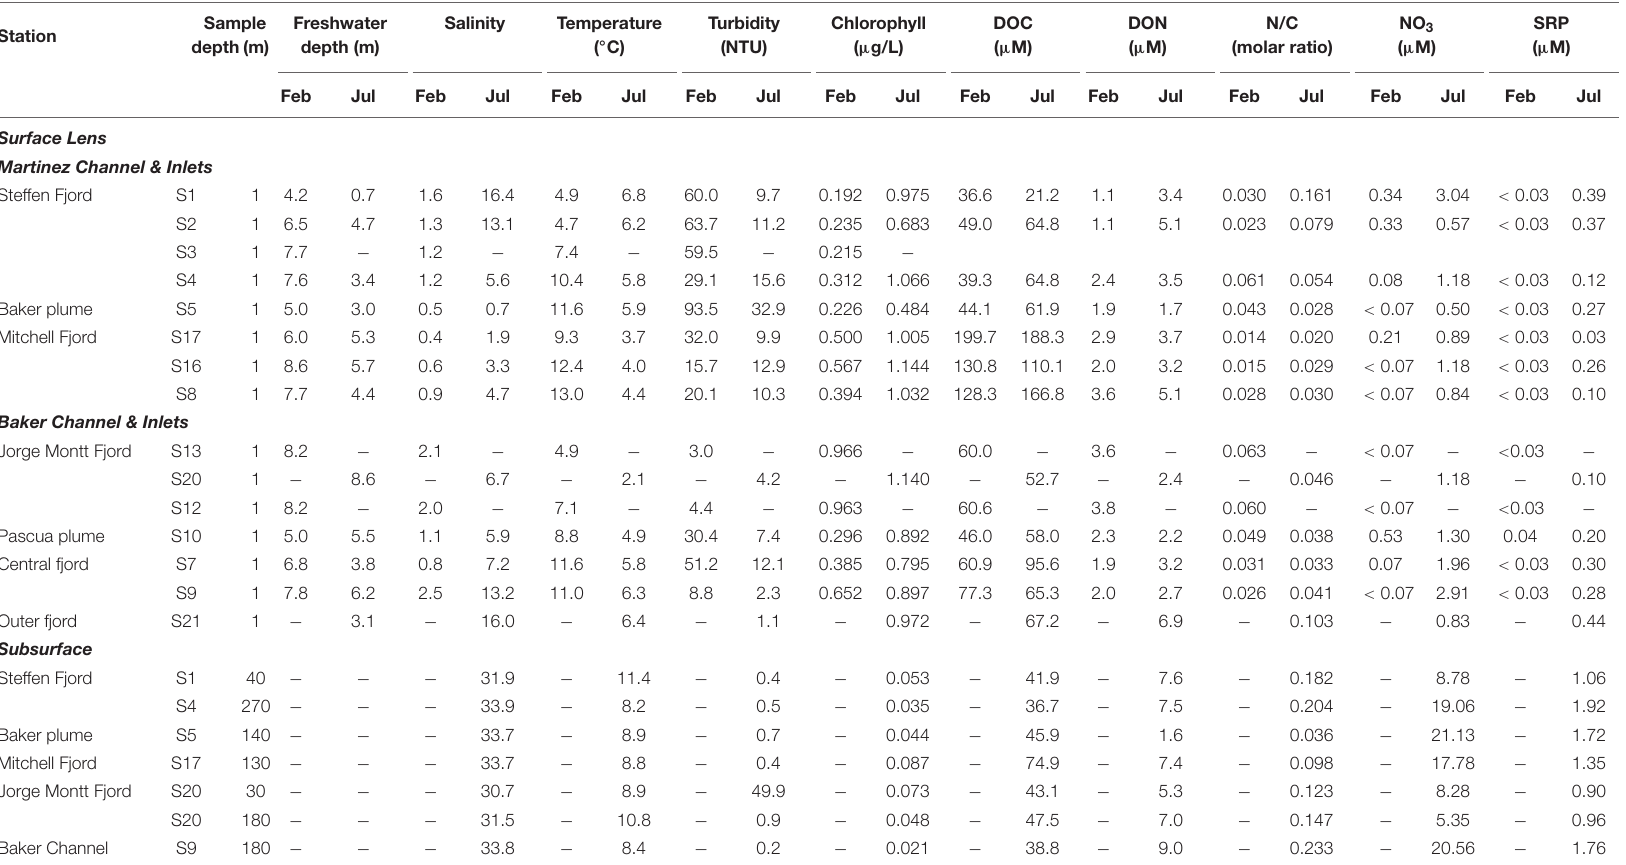
TABLE 1 | Physical and chemical properties of surface layer and selected subsurface depths at survey stations in Baker-Martinez Fjord in austral summer (February) and austral winter (July) 2017. Station